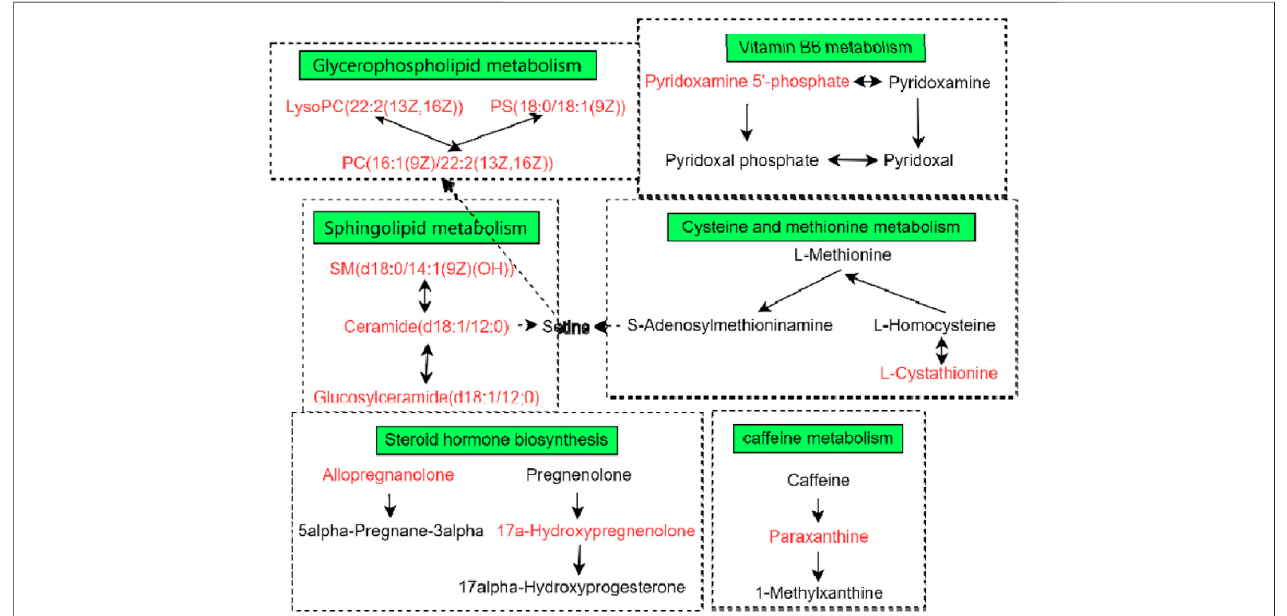
FIGURE 10 | Pathway analysis of plasma samples in 5-HMF-L group.